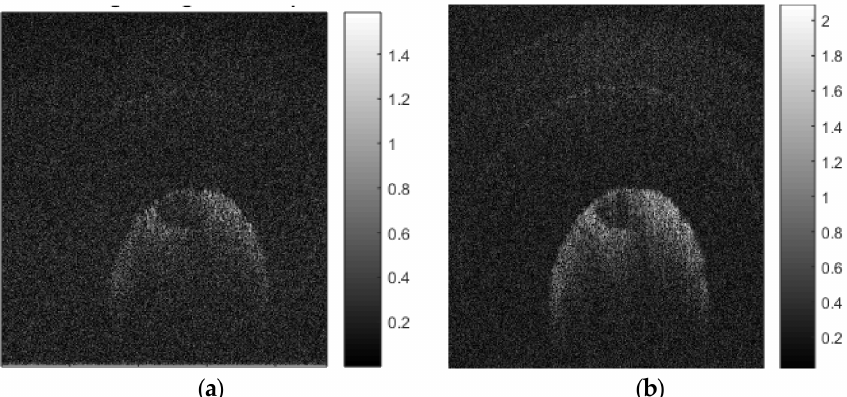
Figure 6. Reconstructed image of a salamander egg using our scaled NDFT with ( a ) 1250 samples; ( b ) 10,000